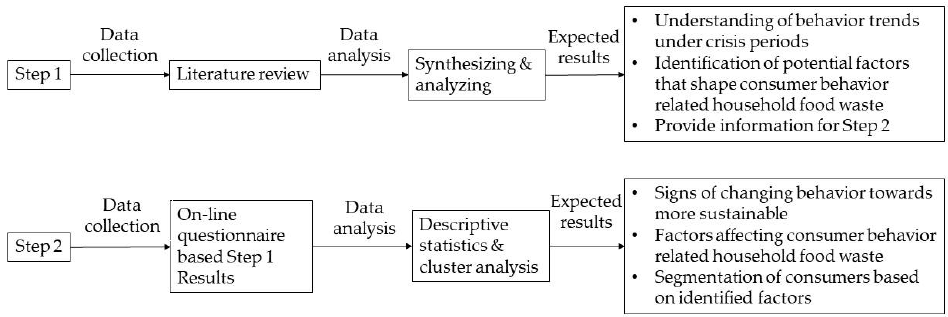
Figure 1. Research flow chart design.